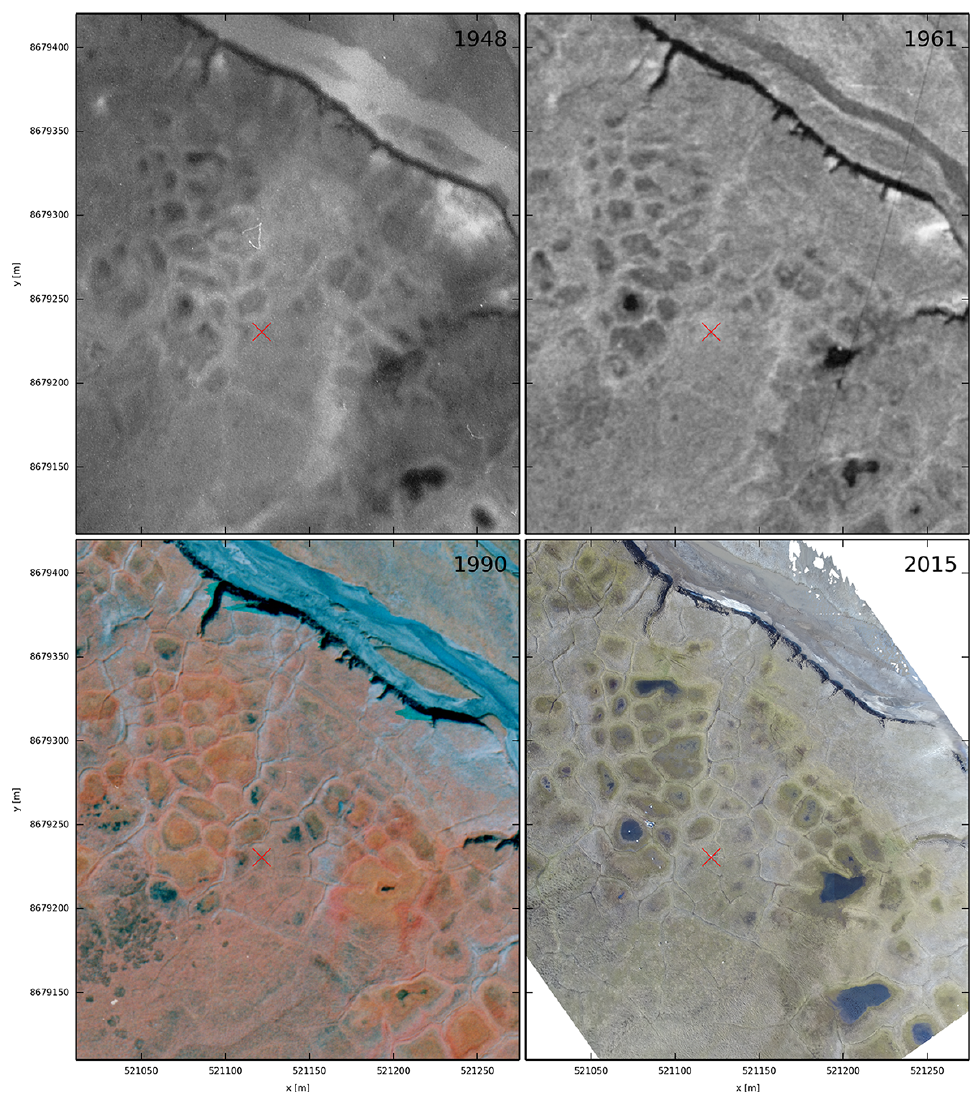
Figure 5. Time series of images of the Adventdalen site showing little sign of differential ground subsidence, which would indicate ice- wedge degradation. The image from 2015 is the same as shown in Fig. 1, while historical photographs were provided by the Norwegian Polar Institute (reference numbers S48-5181, S61-3301, and S90-5273). The images from 1948 and 1961 were taken on panchromatic film, and the image from 1990 is a near-infrared (false color) photograph. The red cross marks the EC